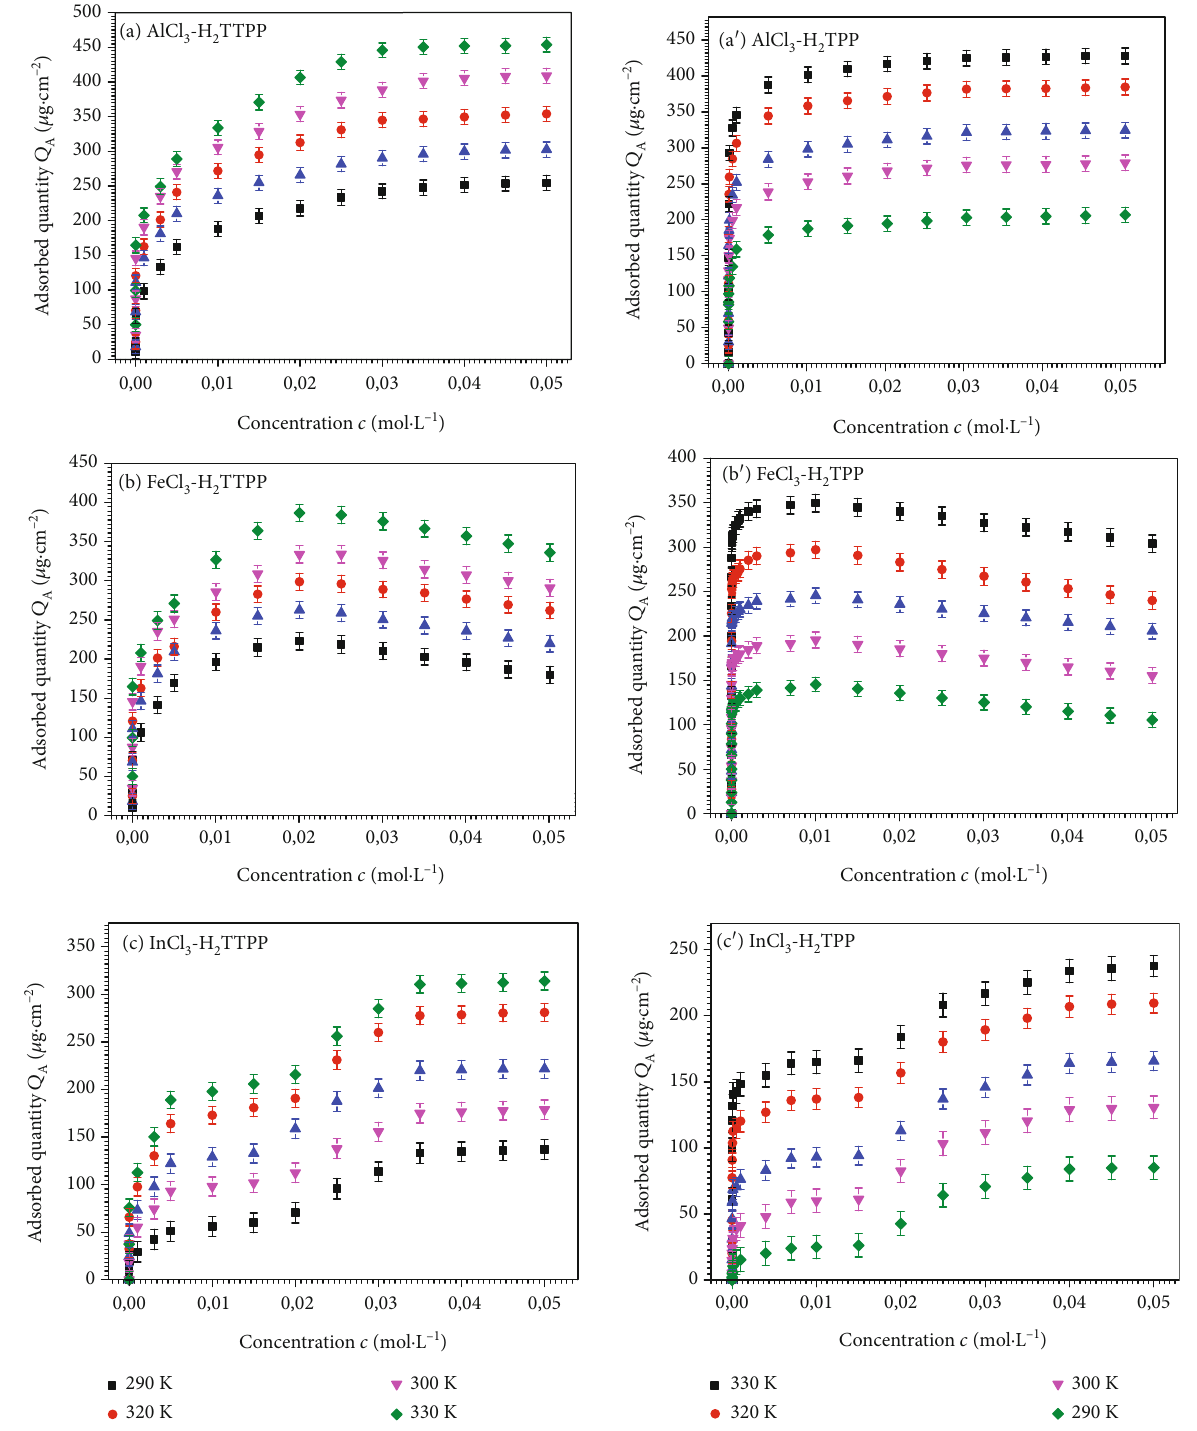
Figure 4: Experimental isotherms of the six adsorption systems given at fi ve temperatures (290-330K): system (a) AlCl -H TPP, system (b) FeCl (a ′ ) AlCl 3 2